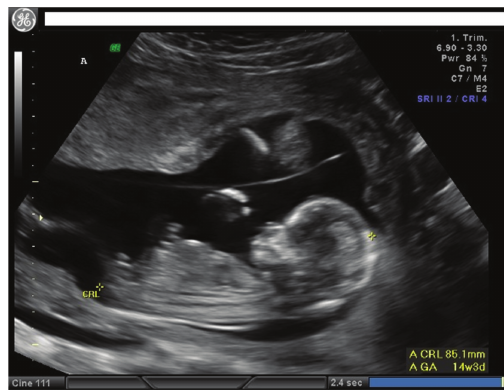
Figure 1: Intact membrane seen at the time of the nuchal scan.